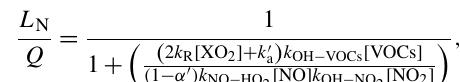
particles, which is not always true in the ambient